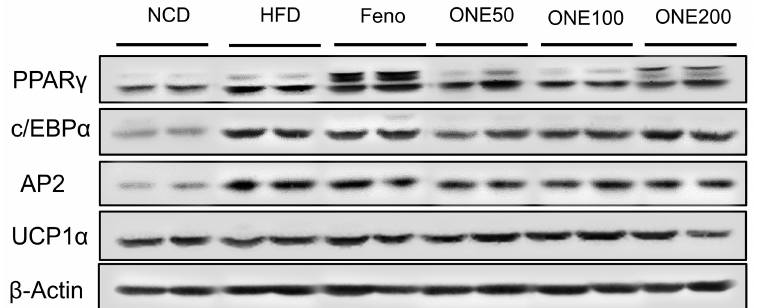
Figure 7. Protein expression levels of PPAR γ , c / EBP α , aP2, and UCP1 α were determined by immunoblot analyses method after four weeks of treatment with NCD, HFD, fenofibrate, or various concentrations of